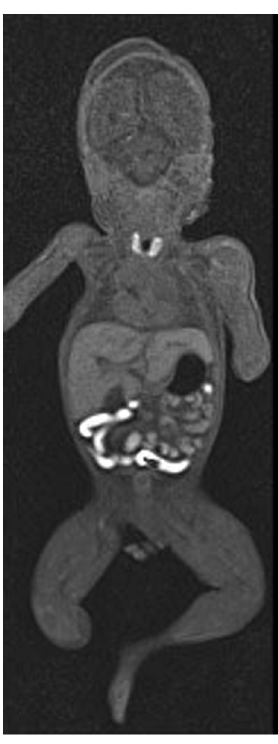
Fig. 1 Coronal T1-weighted (W) image of a 24 weeks gestation fetus showing the normal T1 hypersignal of the meconium and thyroid. The fetal liver appears relatively hypersignal, probably due to high glycogen content